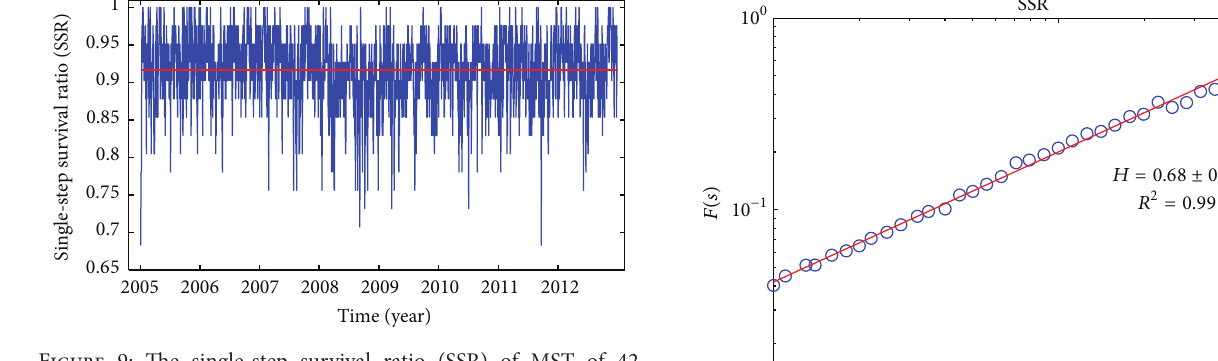
Figure 9: The single-step survival ratio (SSR) of MST of 42 currencies in the international FX market as a function of time. The red solid line stands for the corresponding statistical average value over the time investigated.